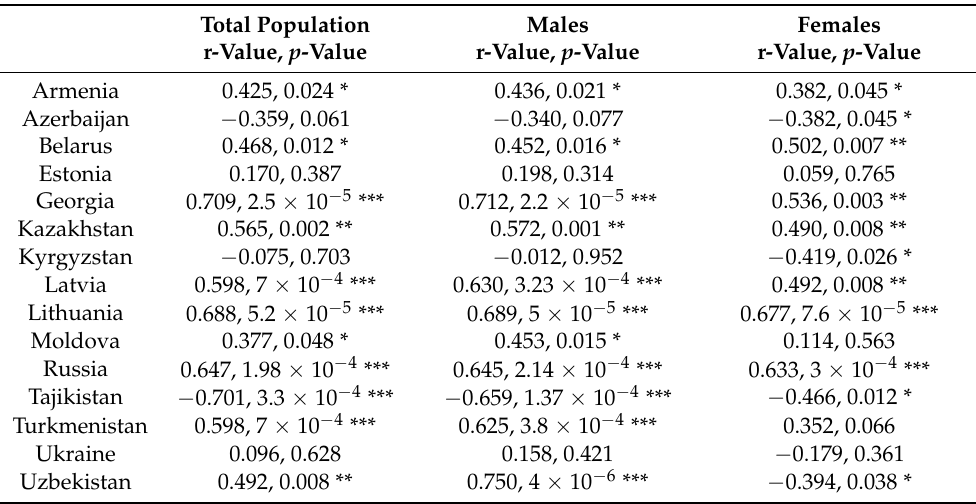
Table 1. Correlations between the suicide rate and unemployment rate in each of the 15 post- Soviet countries. Total Population r-Value, p -Value